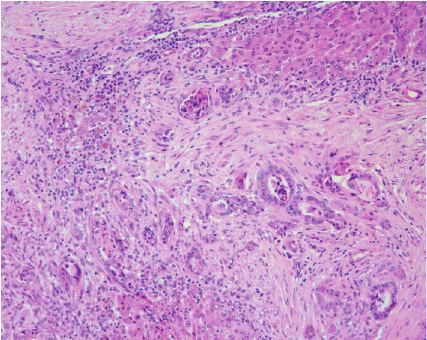
Figure 4: Liver metastasis of uterine adenocarcinoma. The tubular structures infiltrate the interstitial tissue accompanied by dense fibrous tissue and inflammatory infiltrate. Remnants of liver cells can be seen on the left, trapped within the fibrous tissue. Liver lobules are also evident in the upper and lower margins of the image (H&E, ×